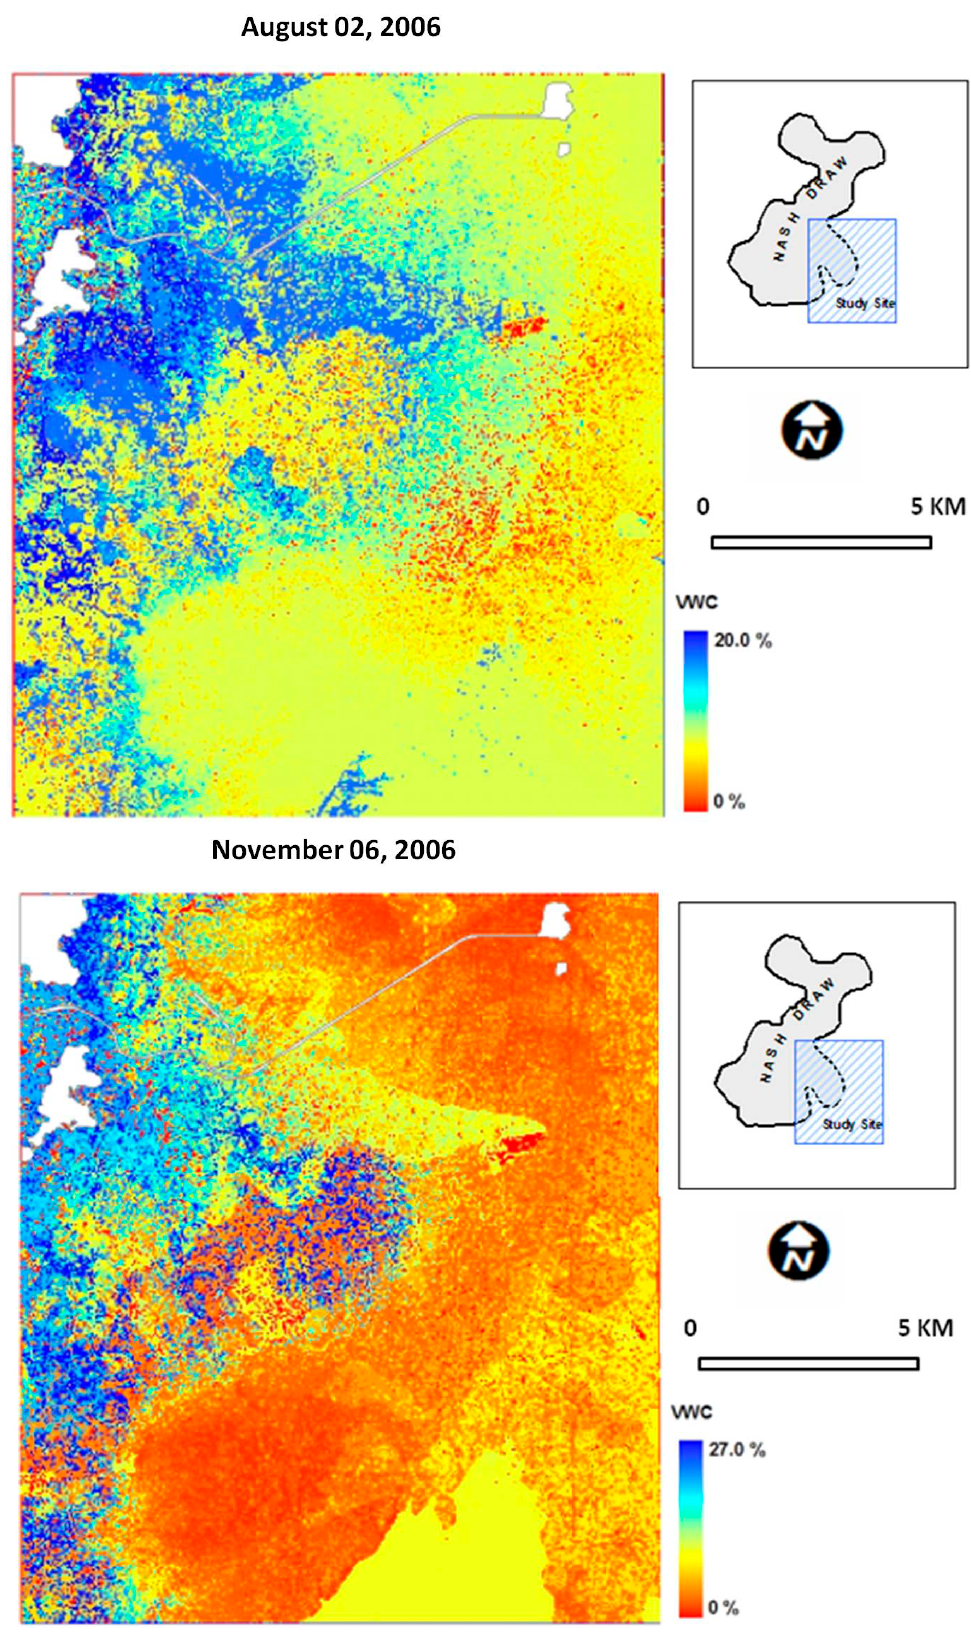
Figure 10. Unclassified soil moisture data generated for the study site.